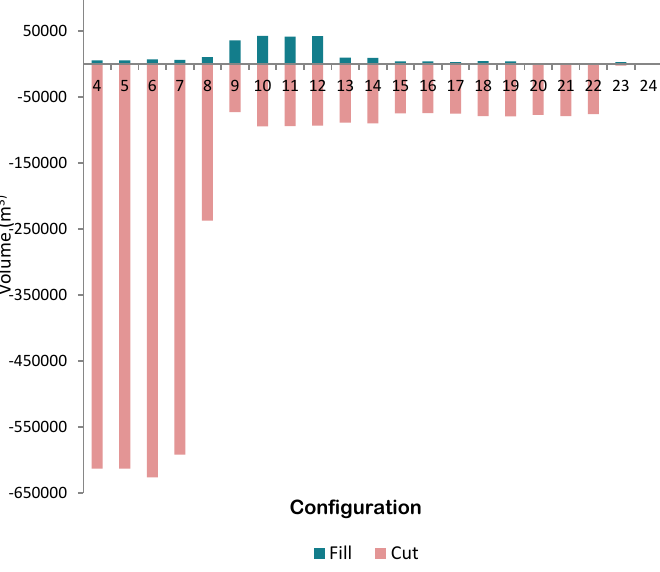
Figure 14. Cut and fill volume